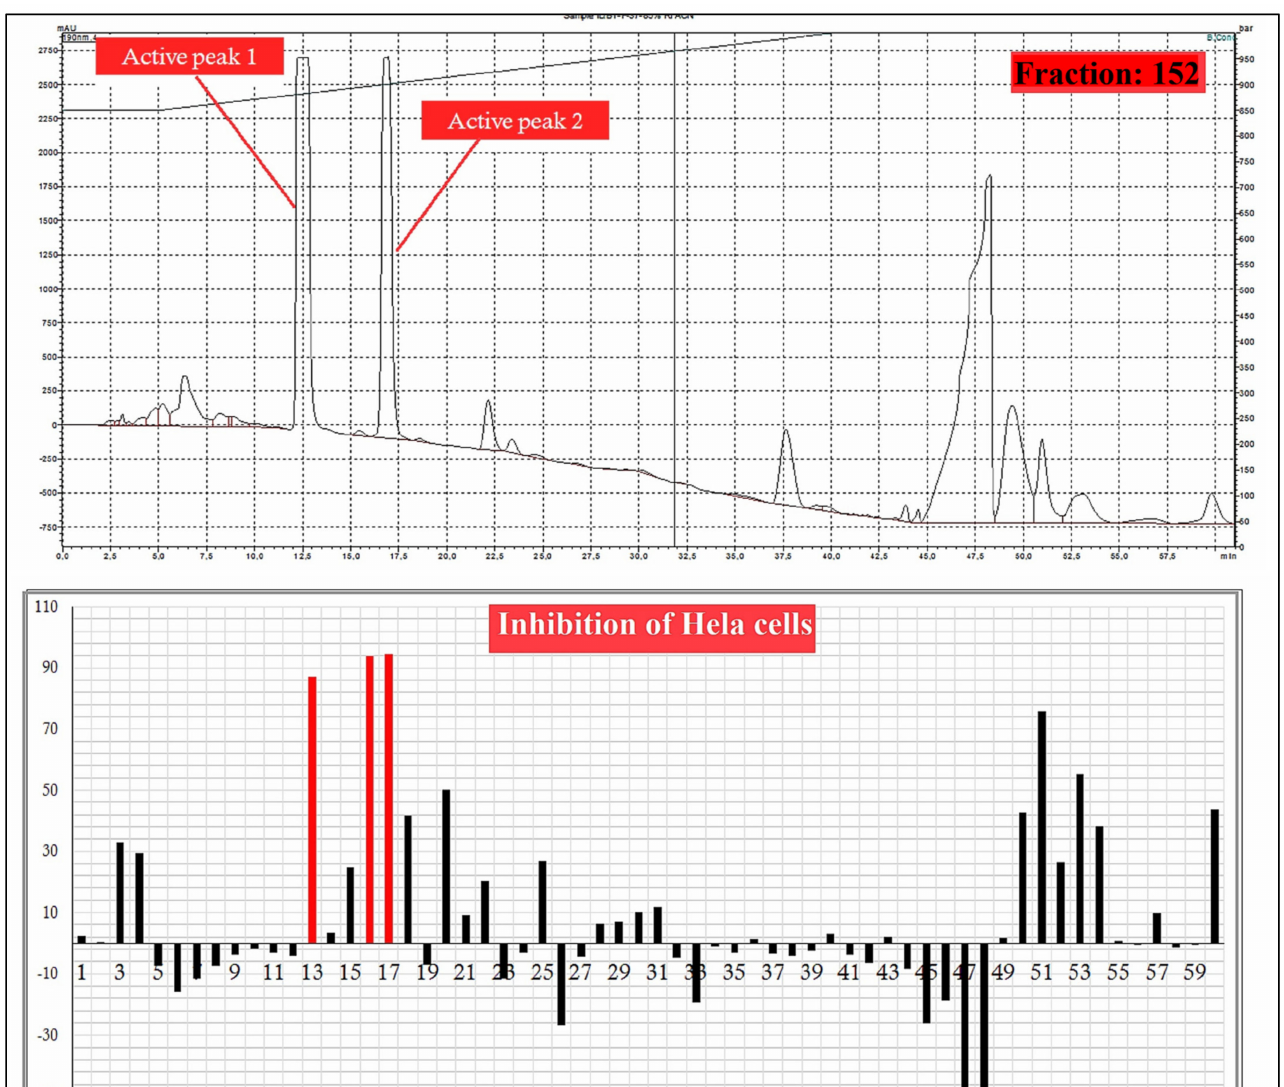
Figure 7. HPLC chromatogram of fraction 152 of silica gel column; percentage inhibition of obtained fractions against cervical cancer cells (Hela) (bottom